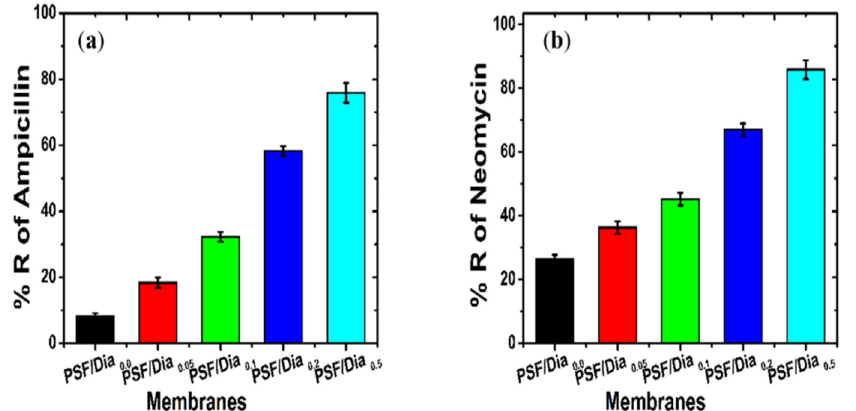
Figure 12. Biomedical pollutants rejection of diatomite composite membranes as compared to control ( a ) Ampicillin and ( b ) Neomycin rejection potential.